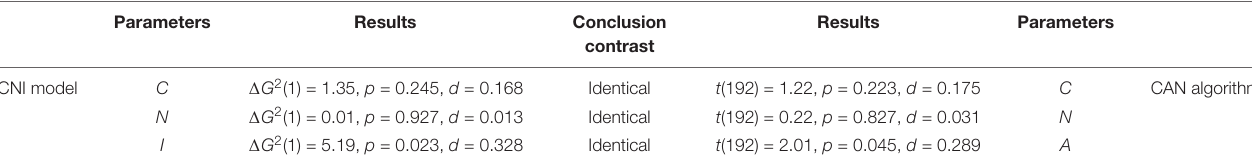
TABLE A1 | Test of differences in cognitive load with the CNI model and CAN algorithm in Study 2a by Gawronski et al. (2017). Parameters Results Conclusion